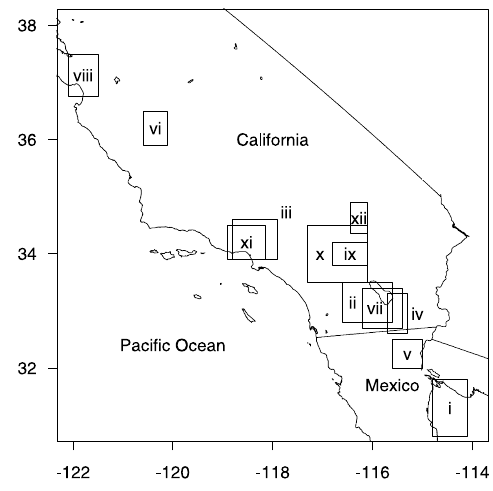
Fig. 2. Areas within which the (cid:115) -precursor and as- sociated major earthquake occurred at: i) Colorado Delta; ii) Borrego Mt.; iii) San Fernando; iv) Brawley; v) Mexicali; vi) Coalinga; vii) Superstition Hills; viii) Loma Prieta; ix) Joshua Tree; x) Landers; xi) Northridge; xii) Hector